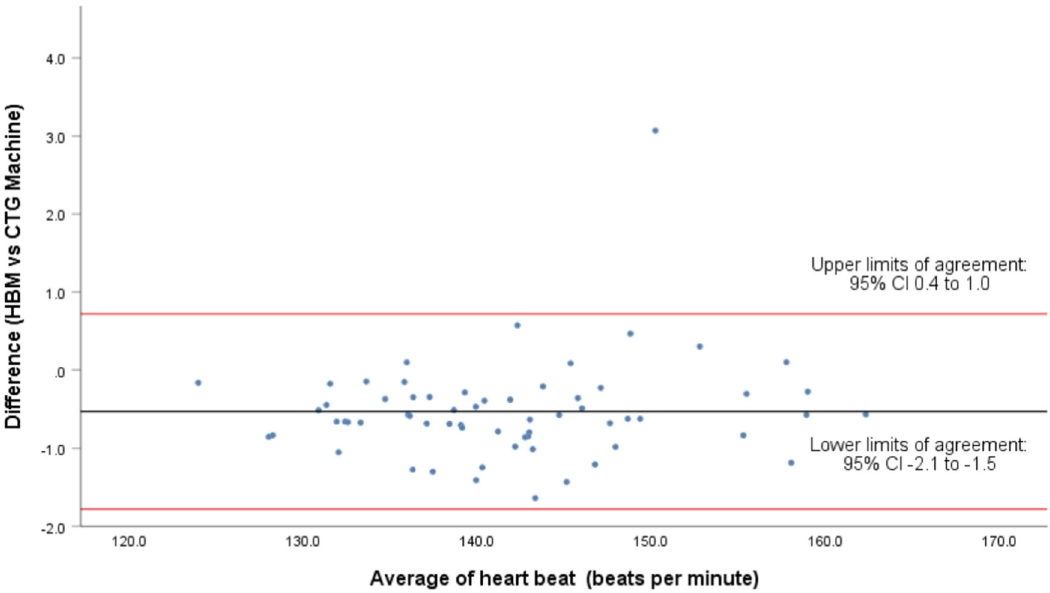
Fig. 2 Bland-Altman plot showing difference in heart rate (beats per minute) between 63 pairs of fetal cardiographs recorded by the fetal heartbeat monitor and cardiotocography. The difference in mean fetal heart rates for each participant was calculated using all data ( n =